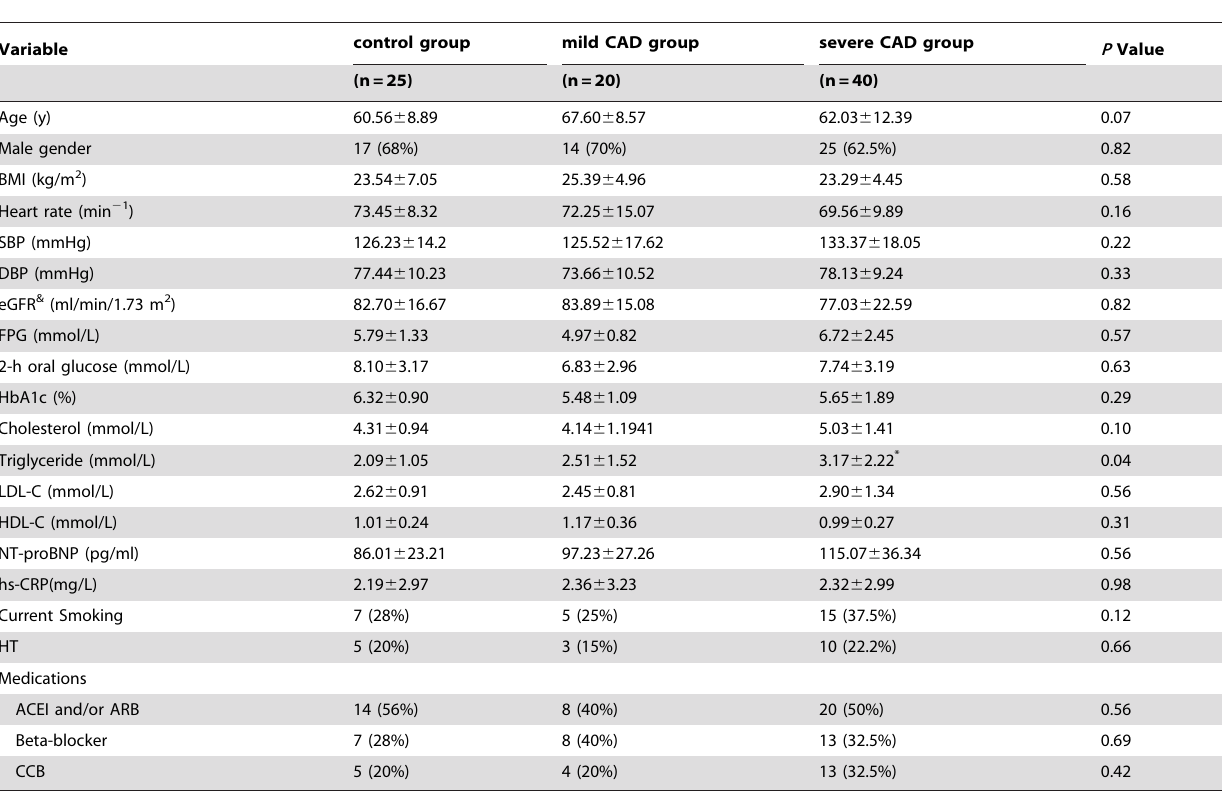
Table 1. Baseline clinical data.